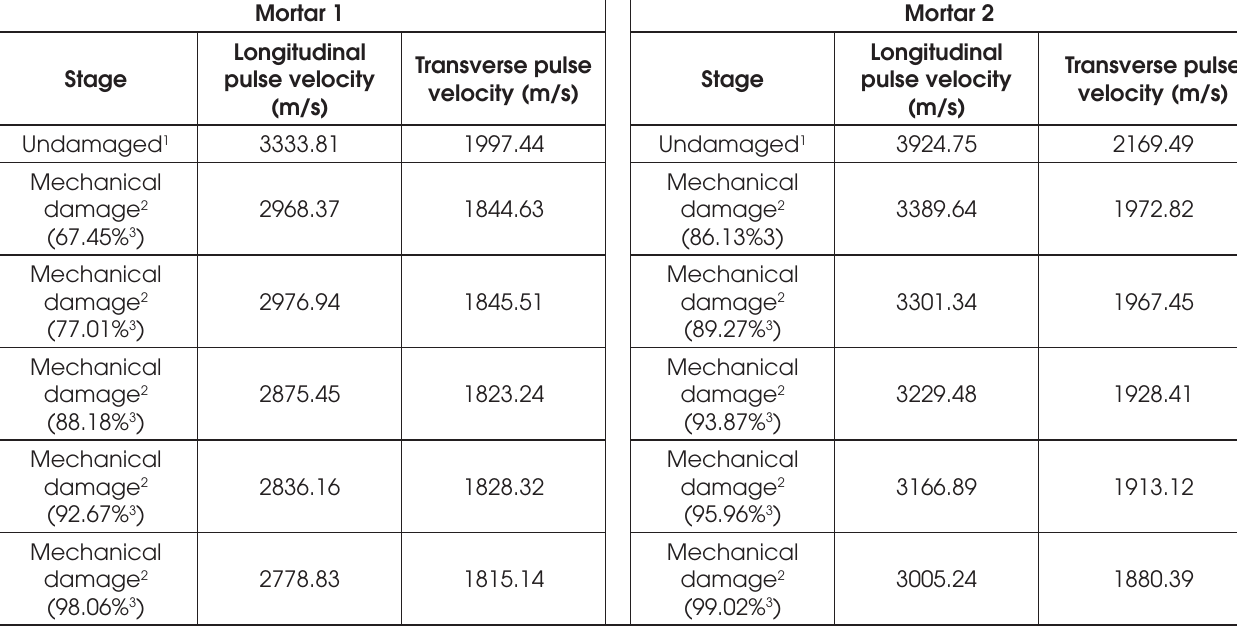
Ultrasonic wave velocities calculated in the finite element model